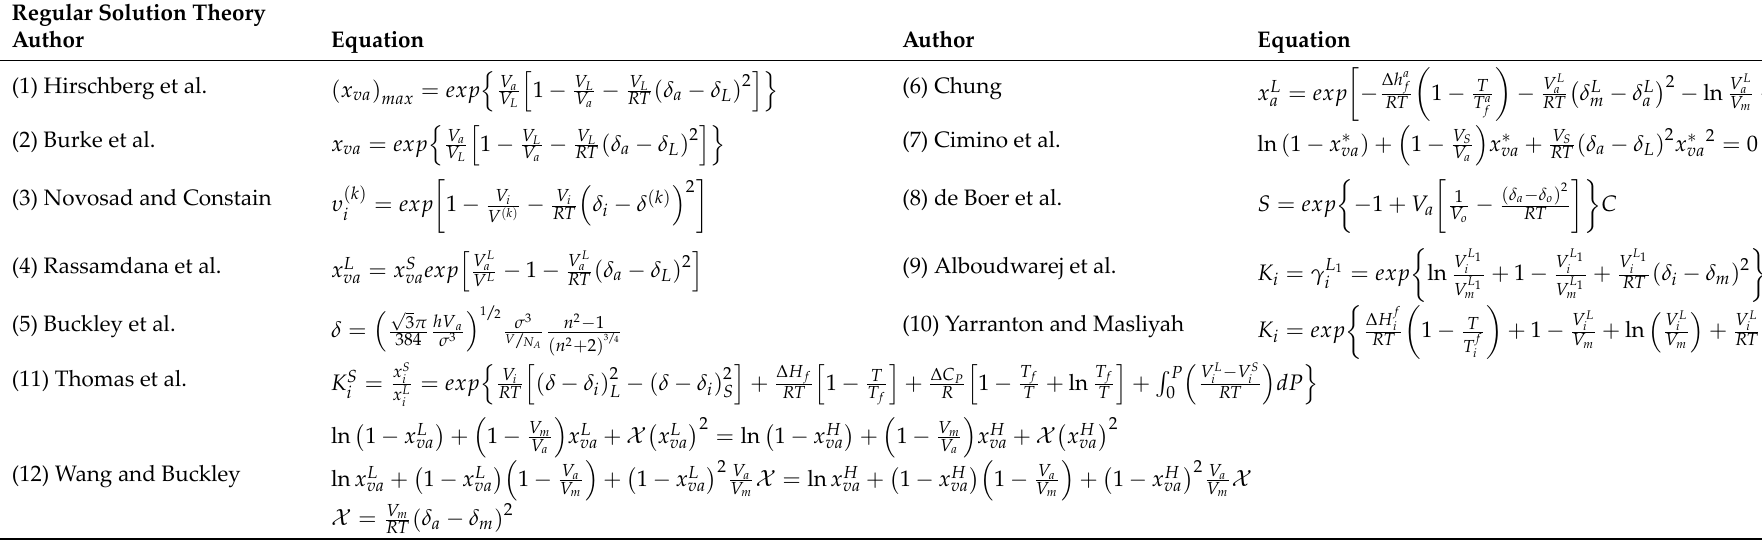
Table 1. Models to calculate asphaltene precipitation based on solubility approach